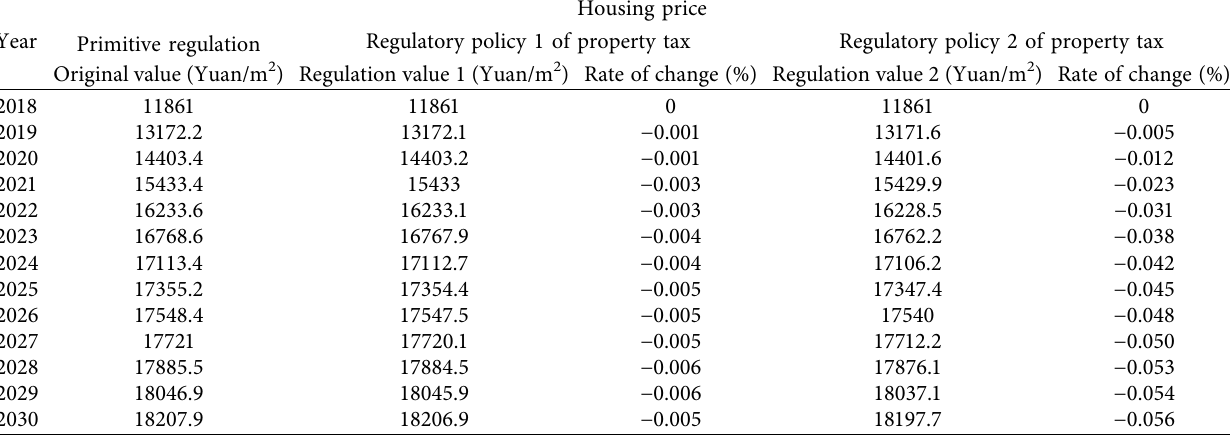
Table 13: Comparison table of housing prices under the regulation of property tax